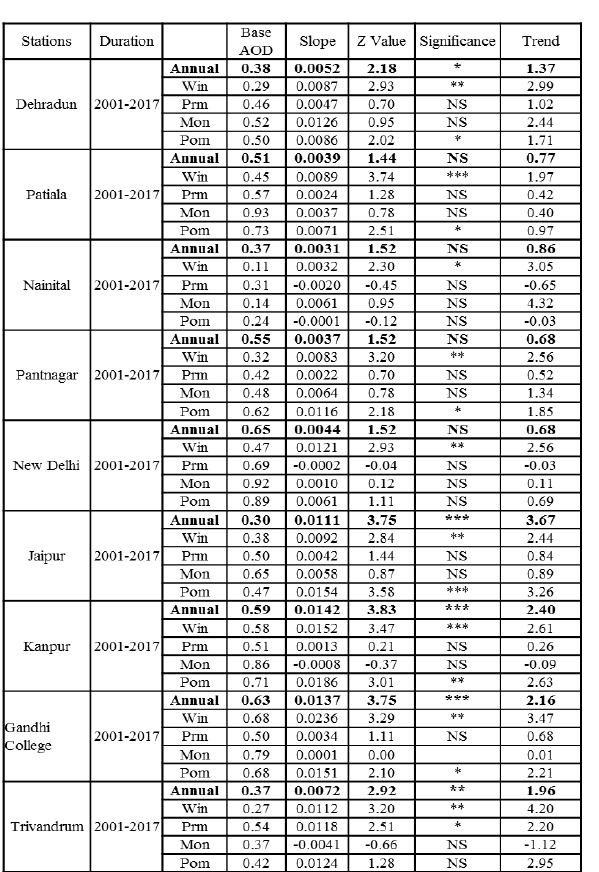
Figure 6. Time series of monthly averaged AOD 550nm at selected stations over India during January 2001-December 2017